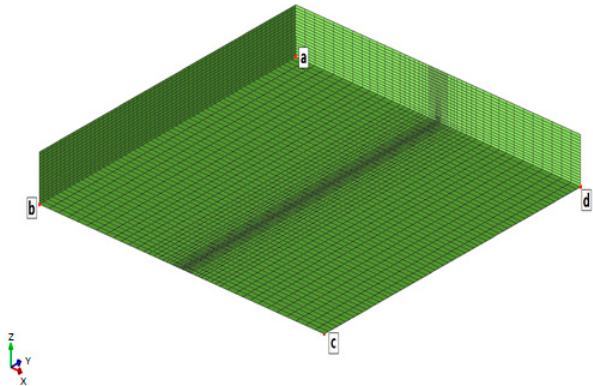
Figure 7. The finite element model and restriction points (a, b, c, and d) of the coupon (a point was constrained in X , Y , and Z directions, b point was constrained in X and Y directions, c and d points were constrained in Y direction).